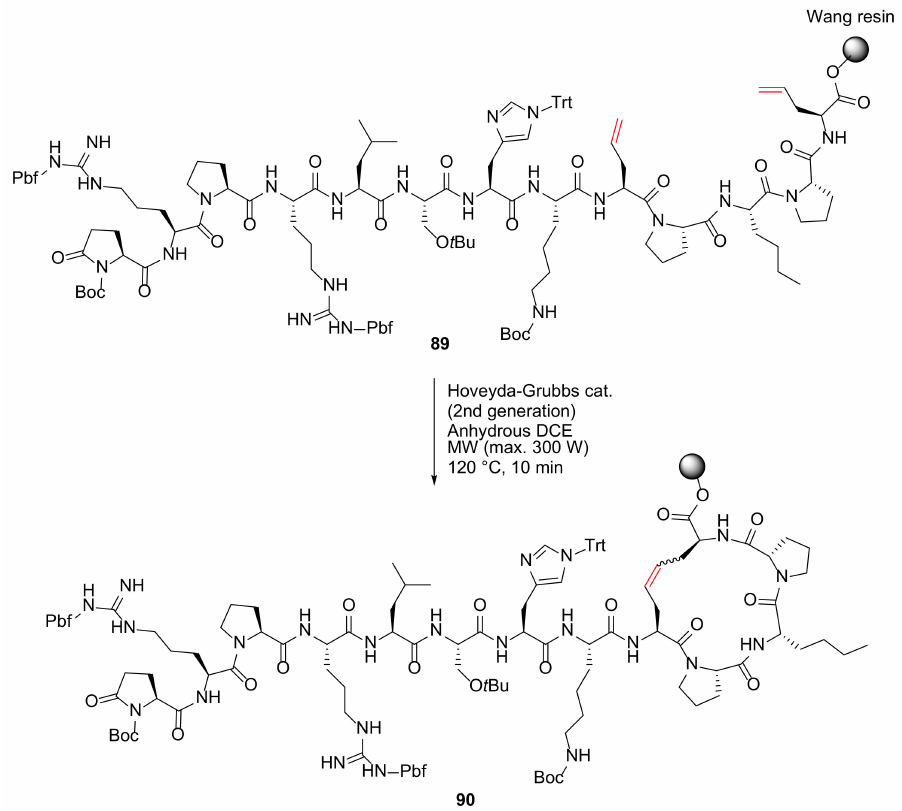
Scheme 26. Solid-supported MW-assisted RCM synthesis of a 17-membered cyclopeptide analog [95]. Other on-resin RCM reactions include the synthesis of a linked amino acid mimetic macrocycle under MW heating by Maxwell et al. in 2013 [96], diverse macrocyclization strategies using on-resin RCM, lactamization and thiol alkylation [97], synthesis of novel echinocandin analogs via on-resin RCM or disulfide formation strategy [98], the synthesis